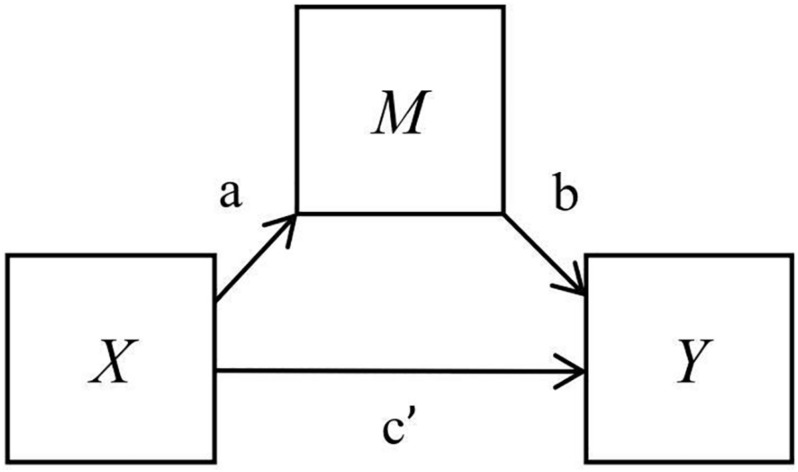
A simple mediation model showing the indirect effect of M on the relationship between X and Y (ab), and the direct effect between X and Y (c’).